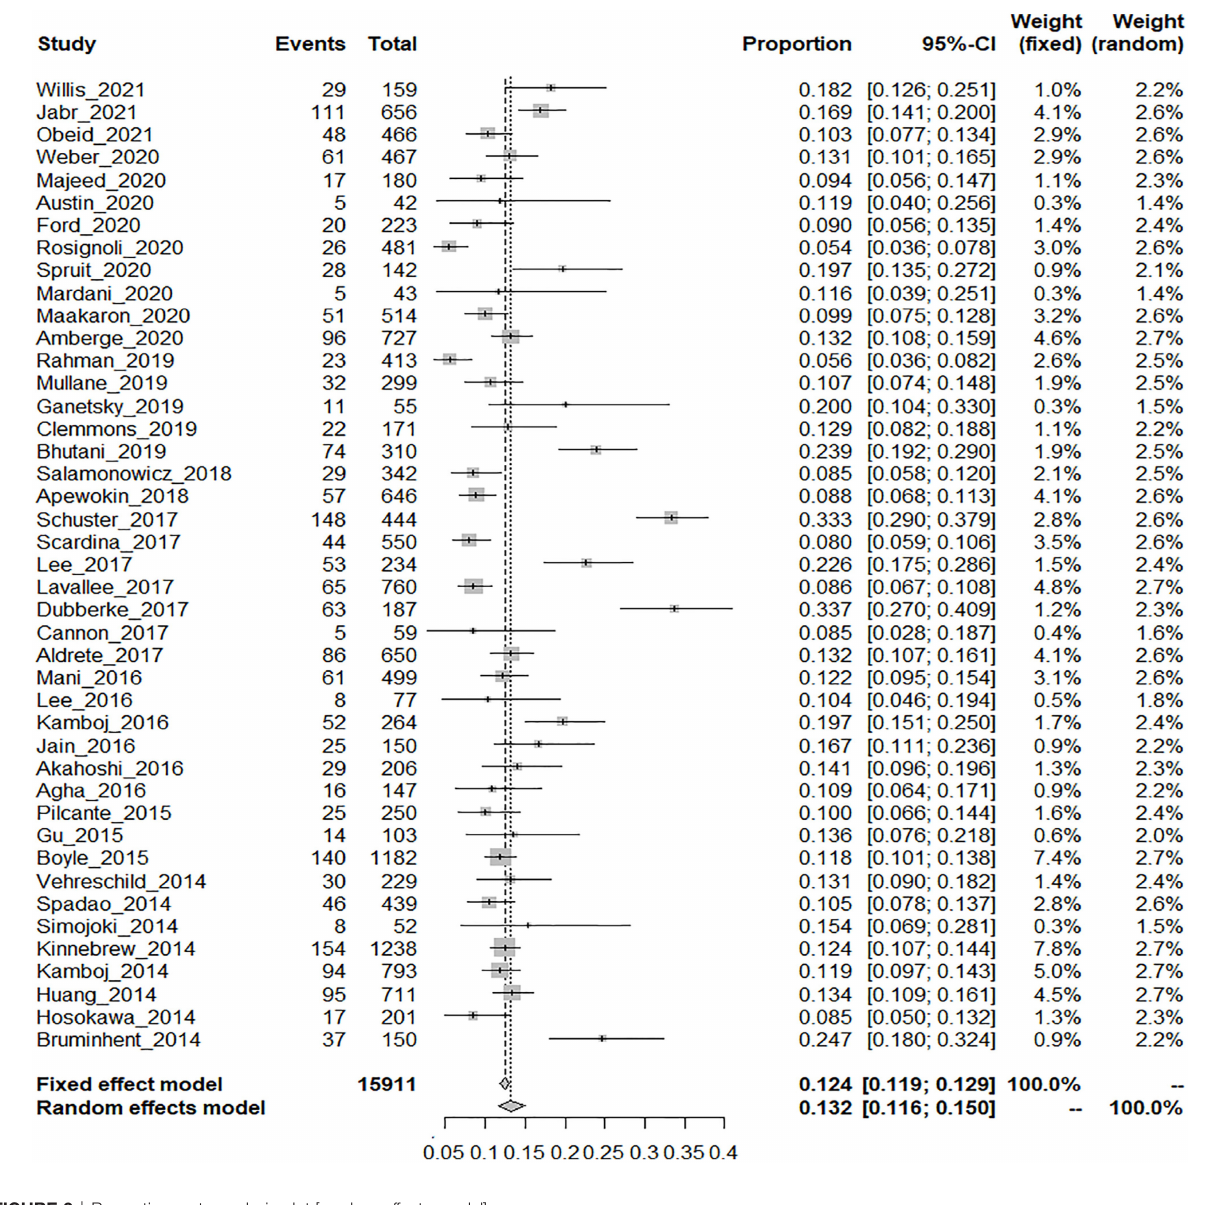
FIGURE 2 | Proportion meta-analysis plot [random-effects